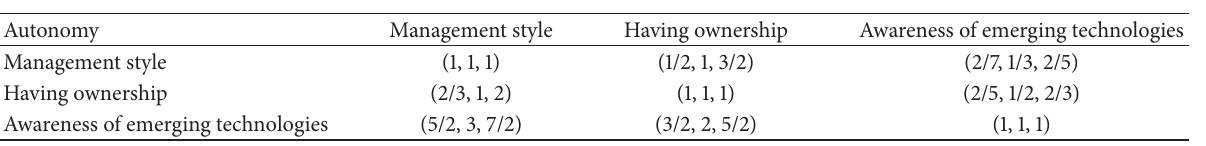
Table 4: Fuzzy pairwise comparisons of the